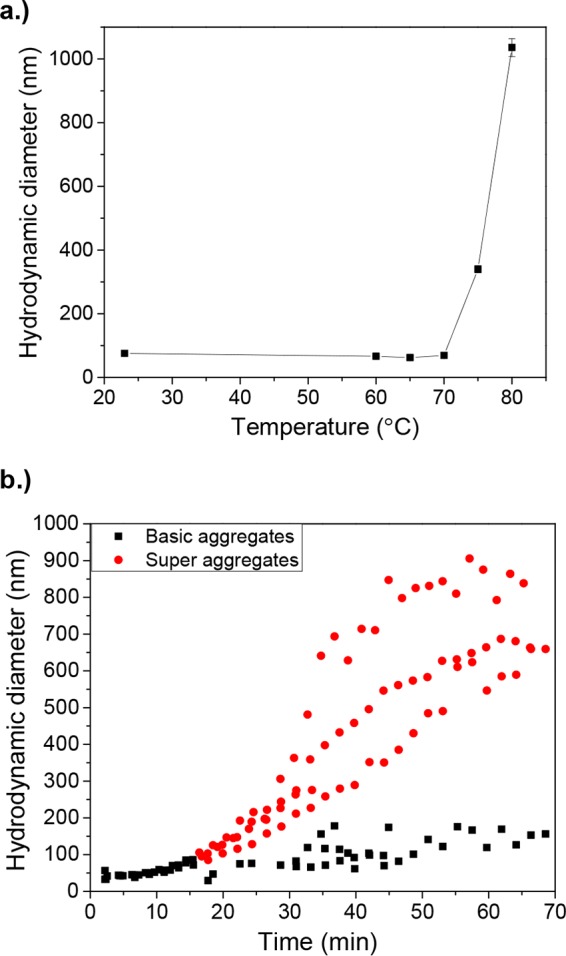
DLS results for SYV VLPs treated at different temperatures and/or times. (a) Hydrodynamic diameter of SYV VLPs treated at different temperatures for 1 min. Error bars represent the standard error of three measurements taken for each of two samples at each temperature. (b) Kinetics of SYV VLP aggregation for three samples treated at 68°C for various times.